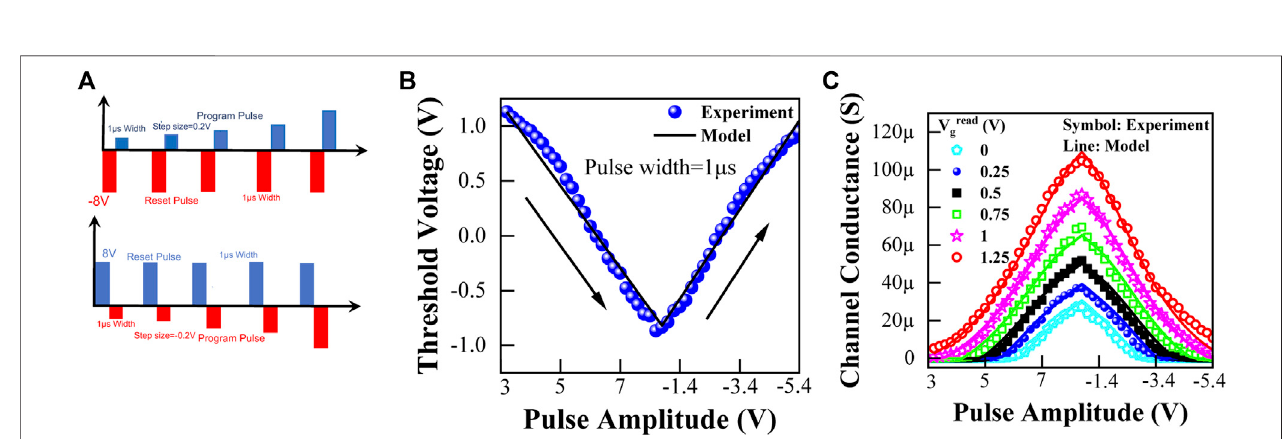
FIGURE3| Schematicillustrationoftheprocess fl owalongwiththeTEMimageforthefrontendoflineintegrationoftheferroelectricthin fi lmwith fi nFETs(Deetal., 2021a; De et al., 2021b).